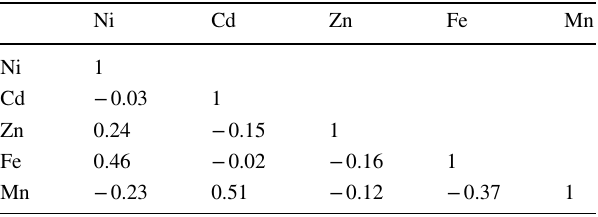
Fig. 5 Variable chart of sample locations Table 7 Correlation matrices of heavy